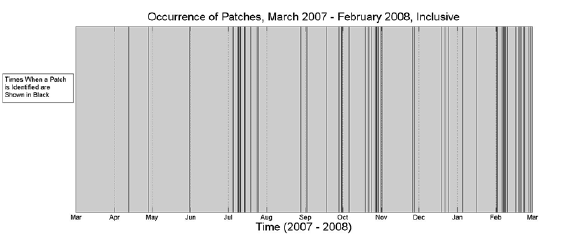
Fig. 6. Seasonal distribution of patches as identified by TRACK. Note peaks of activity in July, October and February.